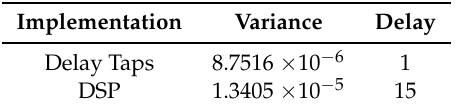
Table 9. Variance and delay of the arithmetic operation